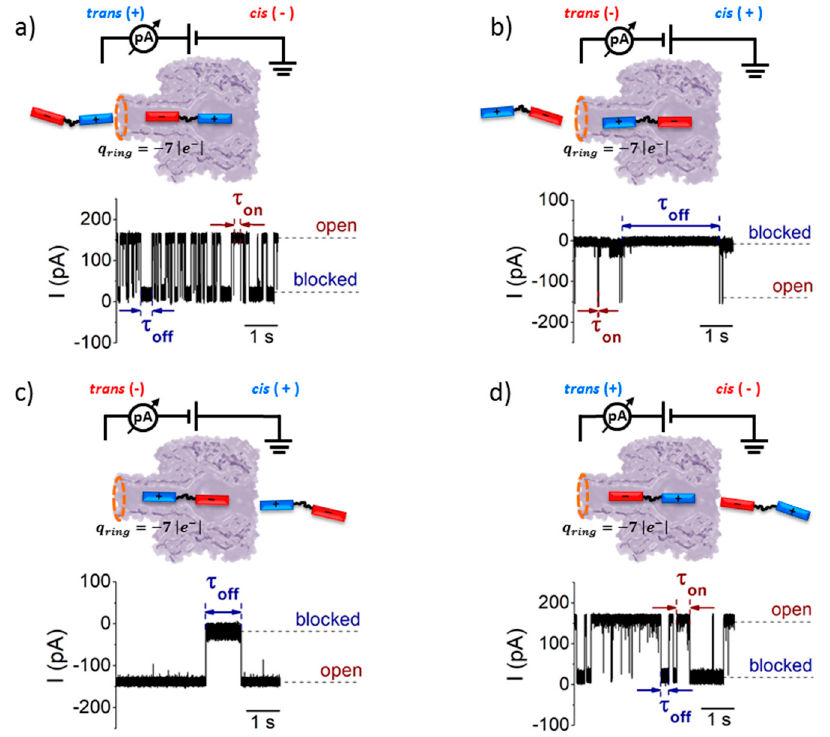
Figure 5. Sketch of the protocol aimed at studying the sidedness dependence of the S 6 -containing peptides- α -HL interactions. The peptide was added to the trans side of the membrane, and positive ( a ) or negative Δ V s ( b ) were employed to drive the peptide vectorially, with either the R 12 or E 12 moiety toward the nanopore’s β -barrel. The selected recordings below illustrate the details of current fluctuation through an α -HL inserted into a planar lipid bilayer, induced by the reversible peptide binding. The times between two consecutive peptide binding events ( τ on ) and of the peptide transient residence inside the nanopore ( τ off ) are also shown. ( c , d ) Precise similar chains of events are represented, except that the peptide was present on the cis side of the membrane. Note that, in this case, to drive the peptide inside the nanopore’s vestibule with the same orientation as above (i.e., R 12 or E 12 moiety head on), opposite polarities of the applied ∆ V s, as compared to those used in ( a , b ), are needed.